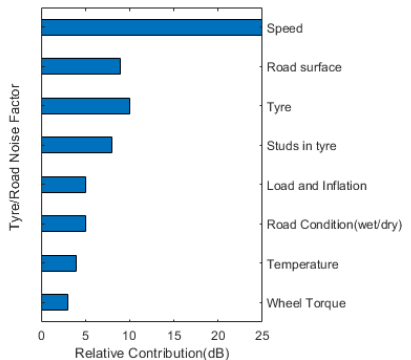
Figure 4. Major factors and their relative contribution to TPIN signal.